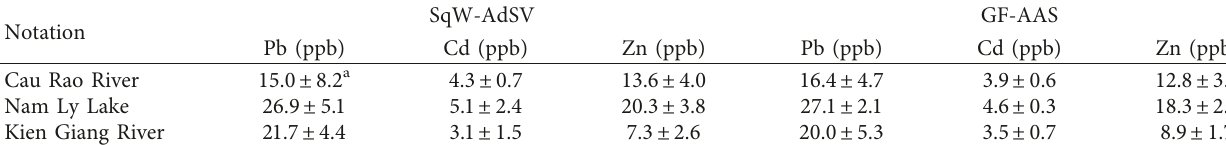
Table 5: Pb, Cd, and Zn concentrations in real samples analysed by SqW-AdSV and GF-AAS. SqW-AdSV Notation